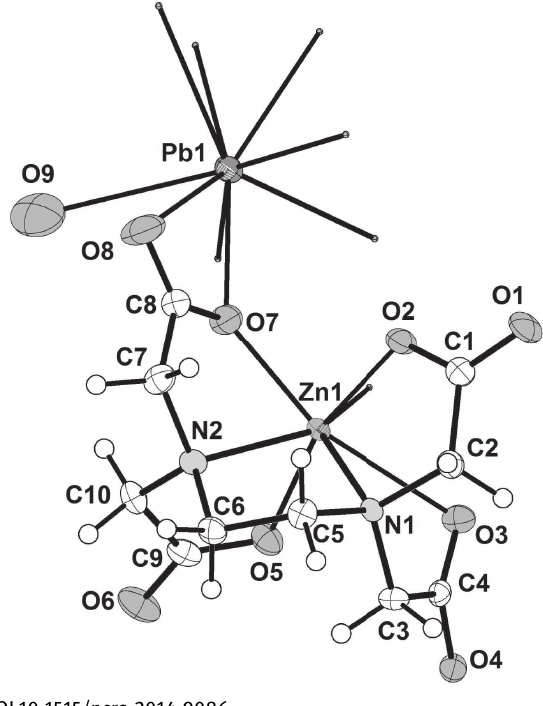
Table 1: Data collection and handling.